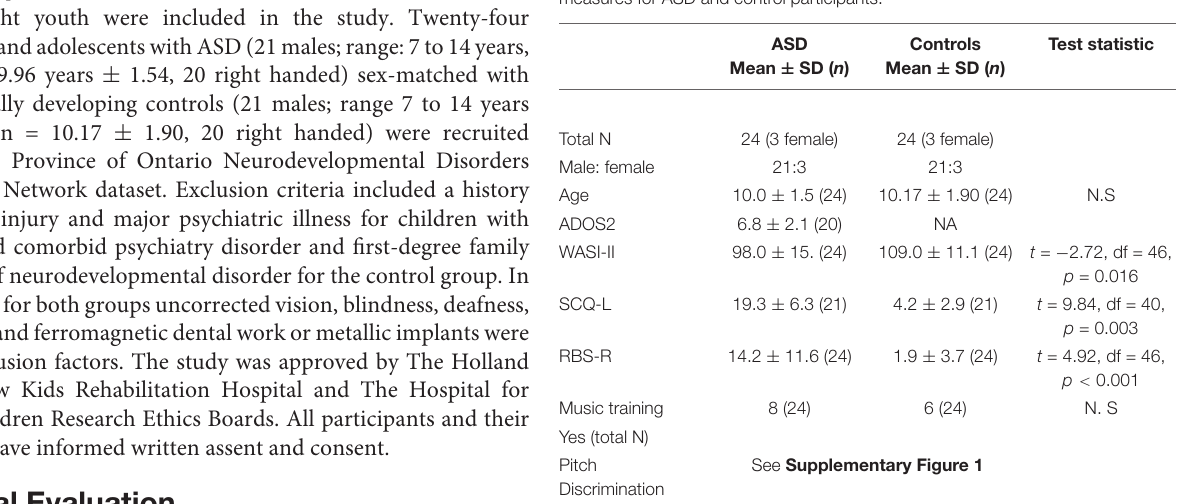
TABLE 1 | Demographic, diagnostic and cognitive-behavioral assessment measures for ASD and control